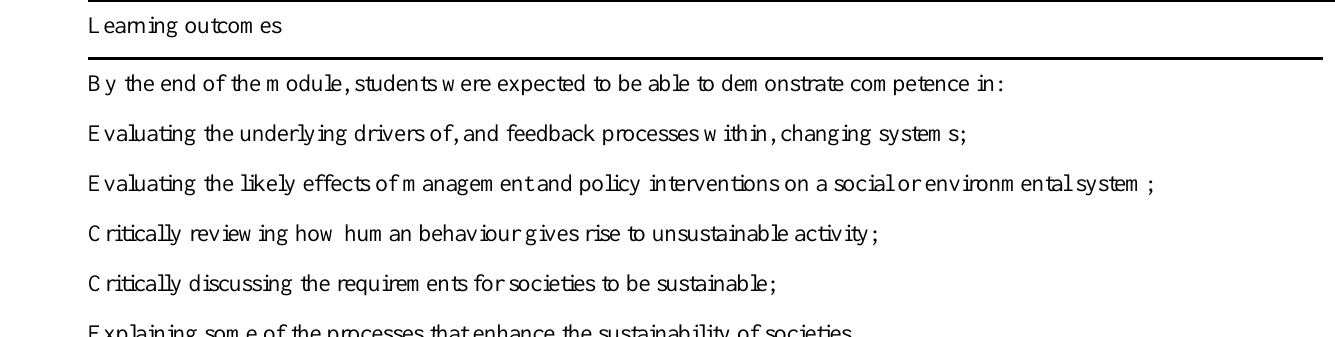
Table 4 . Learning outcomes of the teaching intervention Learning